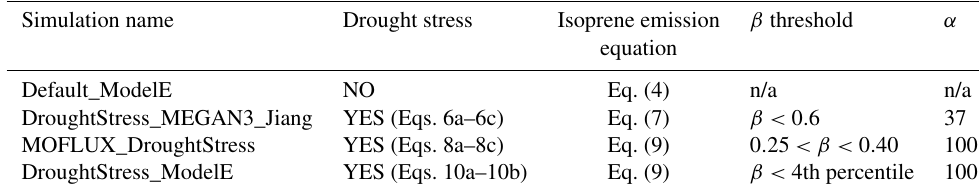
Table 1. ModelE online transient simulation